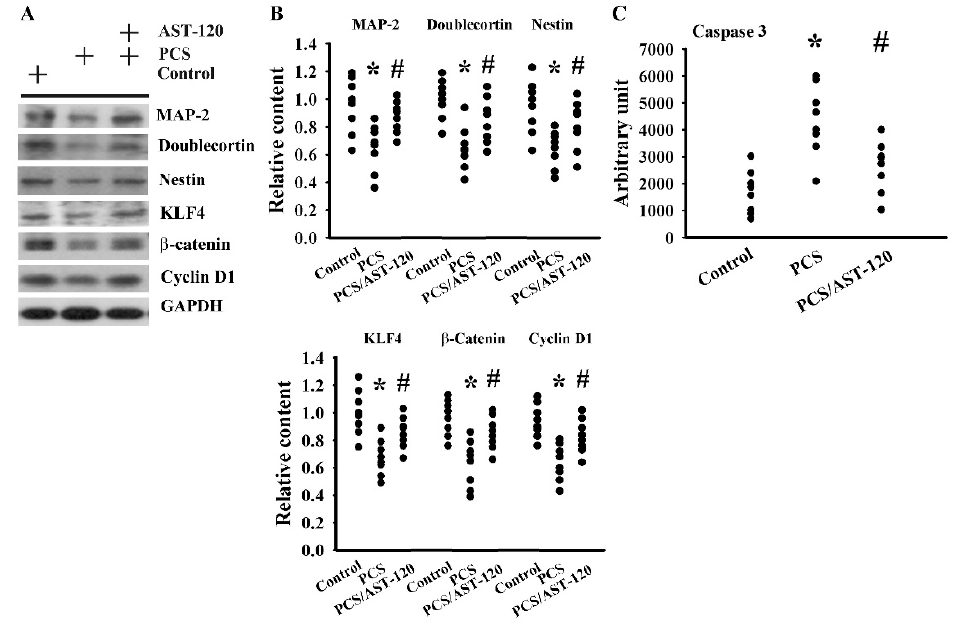
Figure 5. PCS decreased the parameters of neuronal cell survival and neural stem cells. Unilateral nephrectomized mice were intraperitoneally injected with PCS (0, Control; and 100 mg/kg, PCS) and the PCS-injected mice were orally given with AST-120 (400 mg/kg, PCS/AST-120) for 7 weeks. Proteins were extracted from the isolated prefrontal cortical tissues and subjected to a Western blot test with the indicated antibodies. Representative blots ( A ) and the quantitative data ( B ) are shown. Proteins were extracted from the isolated prefrontal cortical tissues and subjected to an enzymatic reaction for the measurement of caspase 3 activity ( C ). * p < 0.05 vs. control group and # p < 0.05 vs. PCS group, n =